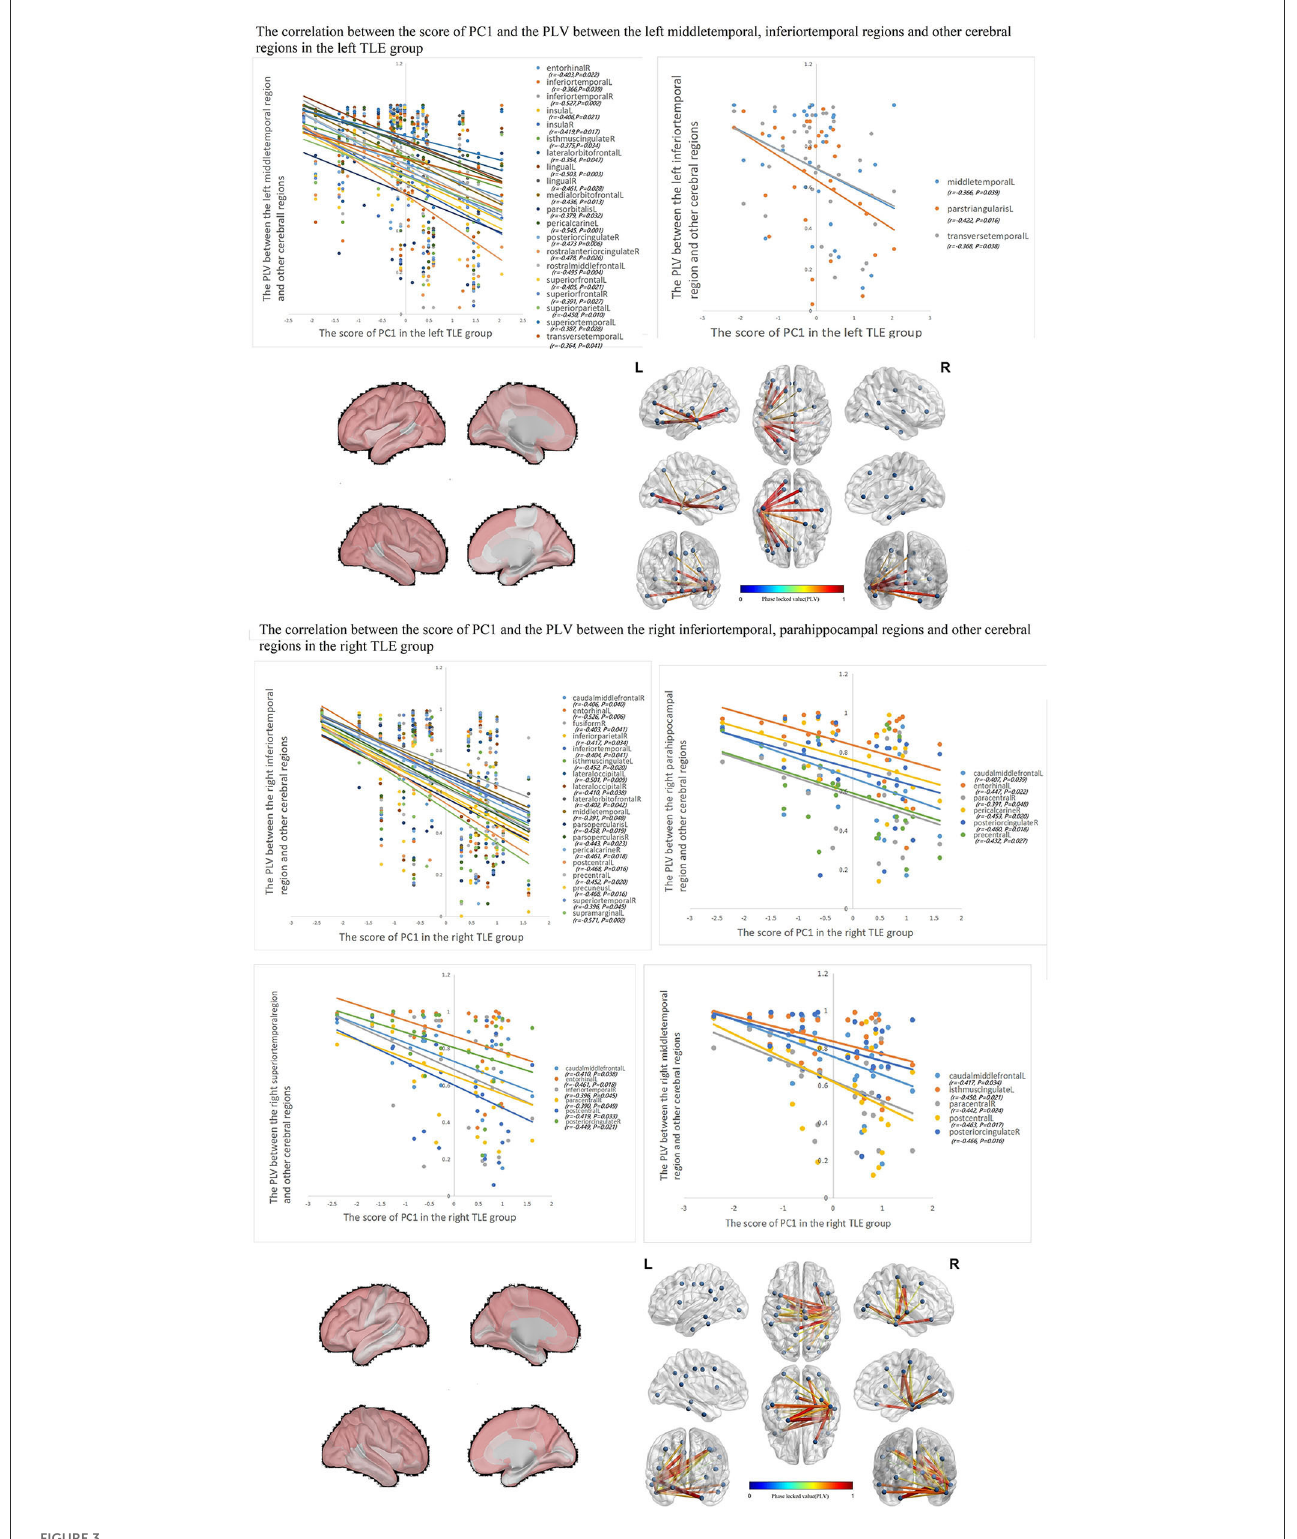
FIGURE3 In each TLE group, the IED source connectivity between the ipsilateral temporal lobe and widespread cerebral regions, which included temporal lobes, frontal lobe, insula, cingulate, parietal, and occipital regions, was negatively correlated with